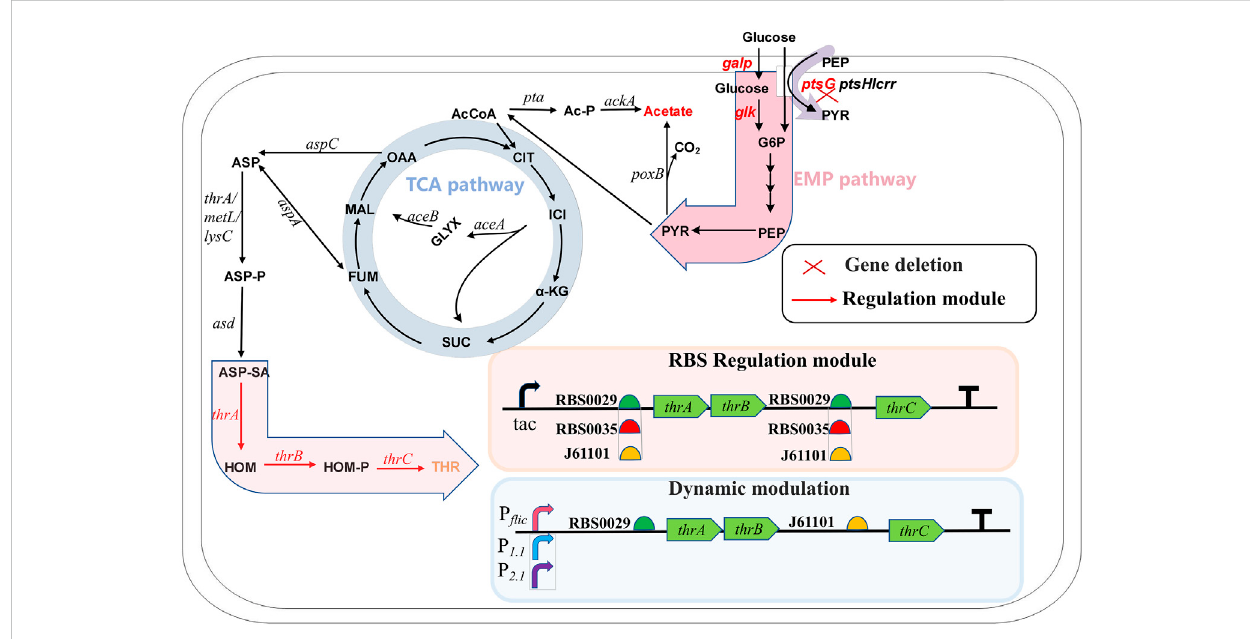
FIGURE 1 The metabolic pathway of L-threonine production in Escherichia coli and the modi fi cation strategy used in this study. G6P, glucose-6-phosphate; PEP, phosphoenol pyruvate; PYR, pyruvate; AcCoA, acetyl-coenzyme A; Ac-P, phosphorylated acetyl coenzyme A; CIT, citrate; ICI, isocitrate; GLYX, glyoxylate; α -KG, α -ketoglutarate;SUC,succinate;FUM,fumarate;MAL,malate;OAA,oxaloacetate;ASP,aspartate;ASP-P,aspartatephosphate;ASP-SA, aspartate semialdehyde; HOM, L-homoserine; HOM-P, homoserine phosphate; THR,